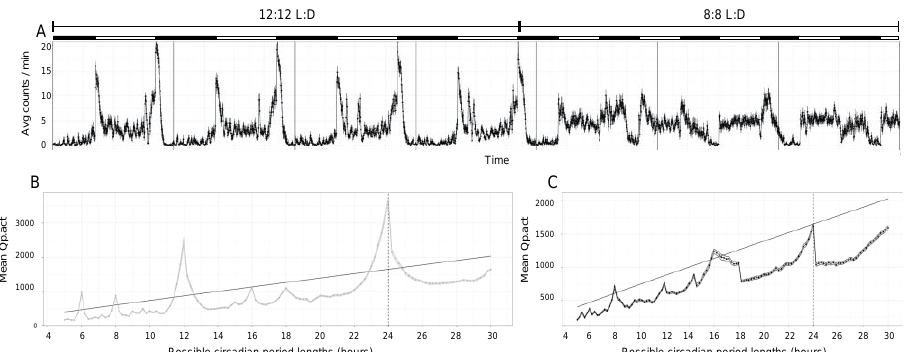
Figure 2. Actimetric analysis of male w 1118 flies (n = 32) under 12:12 L:D and 8:8 L:D conditions. Error bars in all panels indicate standard error. ( A ) Flies show the expected rhythmic bimodal activity pattern under 12:12 L:D, which is degraded when the lighting schedule is shifted to 8:8 L:D. White and black bars above panel indicate periods of light and darkness. Vertical bars in panel indicate 24 h elapsed time. Activity was averaged in five-minute bins. ( B ) Chi-square periodogram for 12:12 L:D shows a clear major probability peak at 24 h, consistent with a 24 h period in activity rhythms. ( C ) Chi-square periodogram for 8:8 L:D shows no clear peak, consistent with reduced rhythmicity. The diagonal line in panels ( B , C ) indicating statistical significance cutoff should be interpreted with caution, as fewer than 10 days of data were analyzed. Activity data file is available as Table S2.